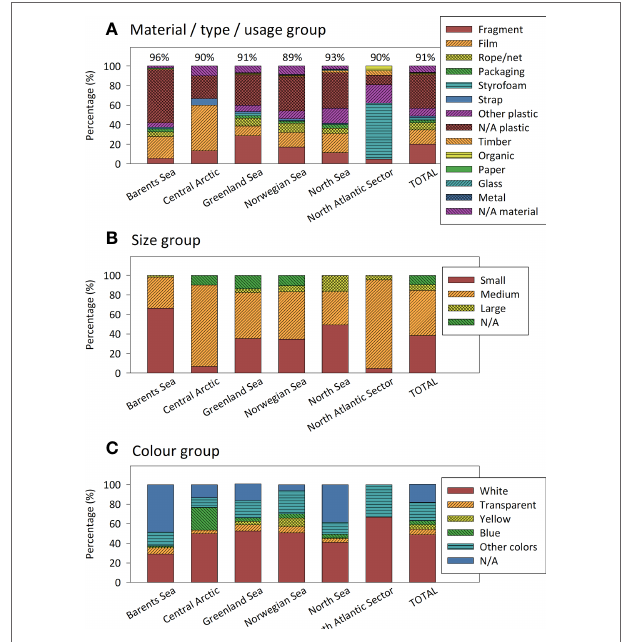
FIGURE 3 | Proportions of debris items according to material, type or usage (A) , size (B) and colour (C) groups. The values refer to proportions (%) within a region and the whole study area (TOTAL). The percentages in (A) above the bars represent the proportion of total plastic items. “N/A” refers to the proportion of the total observed debris within a region and/or category, for which the corresponding detail was not identified. Other plastic items included: bottle, cup, box, buoy/ball, cartridge, chip, cigarette bud, container, sanitary towel, disc, glove, grid, handle, helmet, hose, lid, paint container, photo, printed label, ribbon, ring, rubber, ship paint, sponge, stick, traw, syringe, tube, cotton bud.